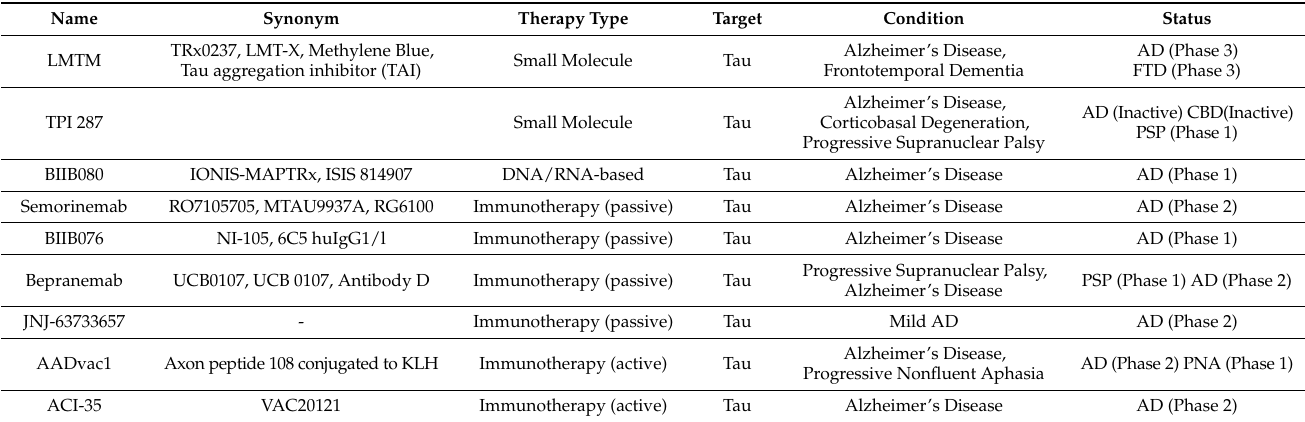
Table 2. List of tau-targeted current trial